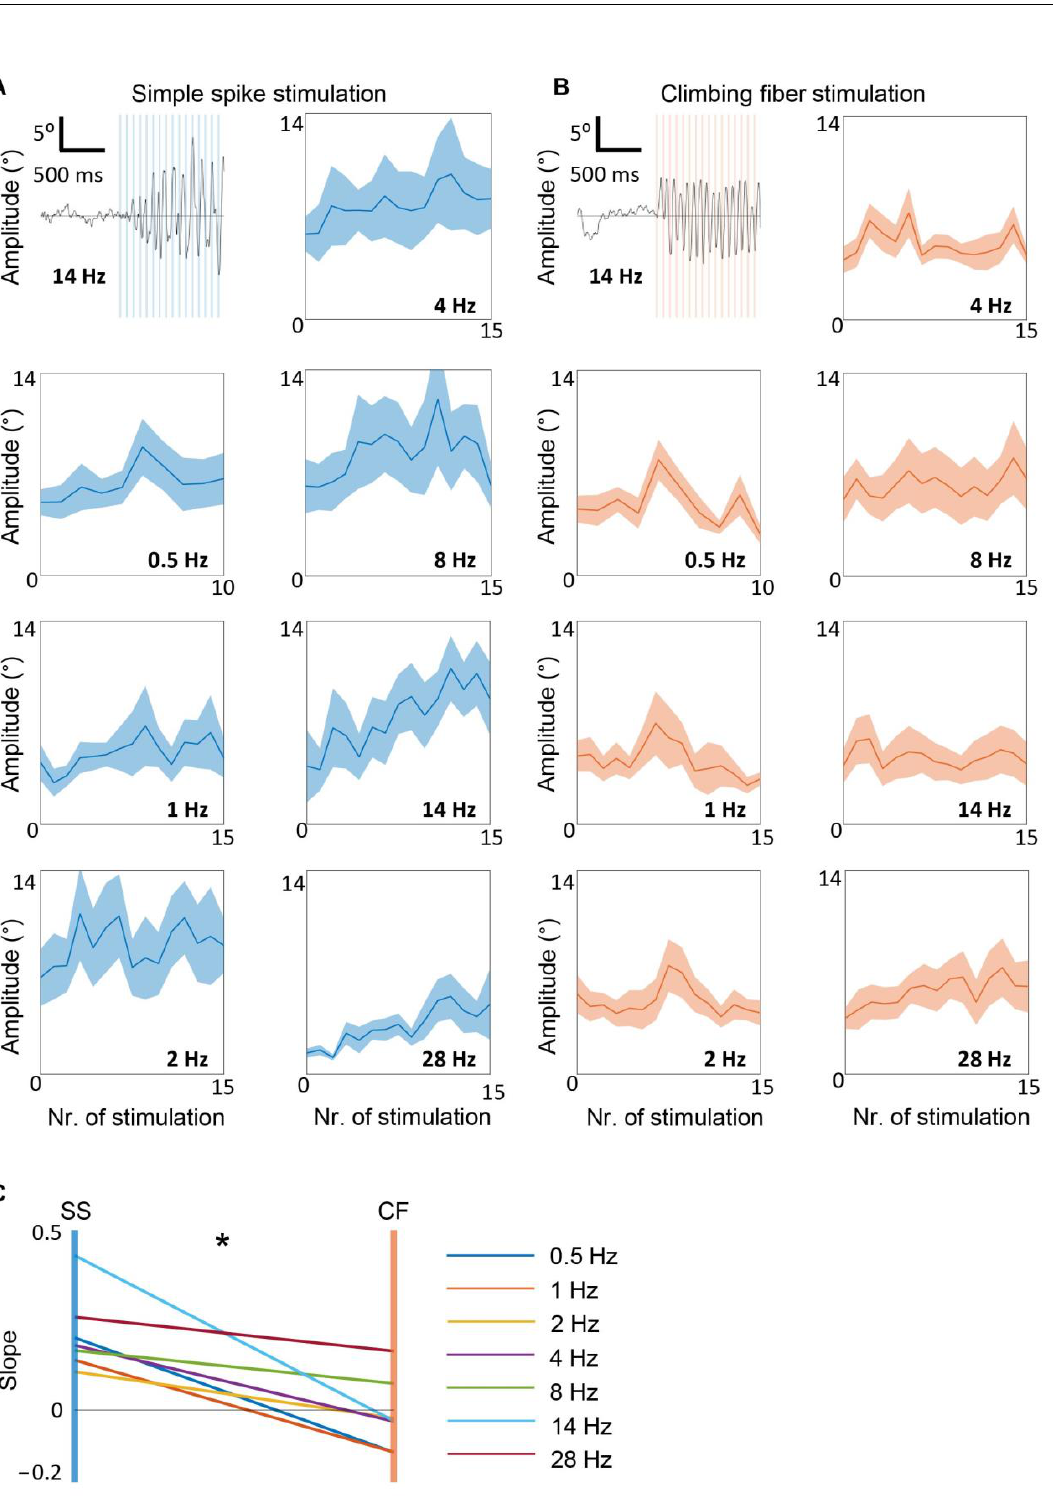
Figure 4. Simple spike, but not climbing fiber stimulation entrains whisker movement. ( A ) shows an example of whisker raw trace during the first 15 pulses of SS stimulation at 14 Hz (upper left). Vertical blue bars represent stimuli. Note how the amplitude gradually increases over time. The mean whisker amplitude during the first 15 stimulations is shown for 1, 2, 4, 8, 14, 28. For 0.5 Hz are shown only for 10 stimuli (corresponding to the total number of stimuli given at that frequency). ( B ) is similar to ( A ), but for climbing fiber stimulation. ( C ) shows that the values of the slopes during SS stimulation were higher than during climbing fiber stimulation ( p = 0.0047, paired sample t -test). The symbol * indicates that p -value is